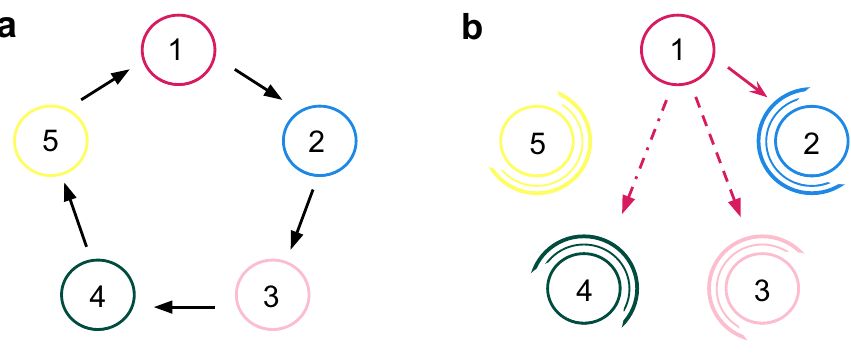
Figure 1. Selection rules and directional movement tactics. ( a ) Illustration of the selection rules among the species, which represents a generalisation of the rock-paper-scissors game. ( b ) Illustration of the directional movement tactics for individuals of species 1. The solid ruby line represents the Attack tactic, where individuals move towards the direction with more individuals of species 2. The dashed ruby line shows the Anticipation tactic, that is a movement towards the path with more individuals of species 3. The dashed-dotted ruby line illustrates how individuals move when they perform the Safeguard tactic, going towards the direction with more individuals of species 4. The concentric circumference arcs in the right panel illustrate that individuals of species 2, 3, 4, and 5 always move randomly.